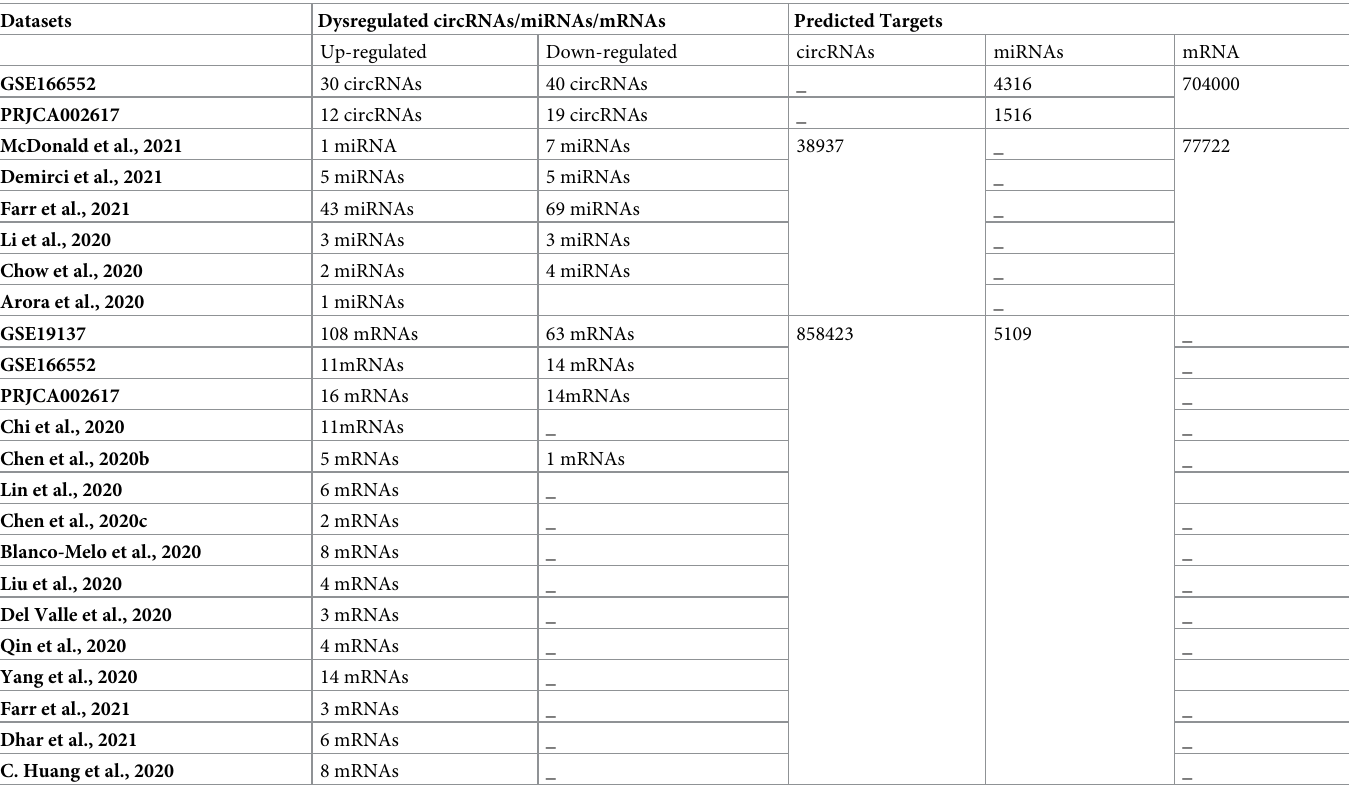
Table 3. List of count of differentially expressed RNAs and their predicted targets.